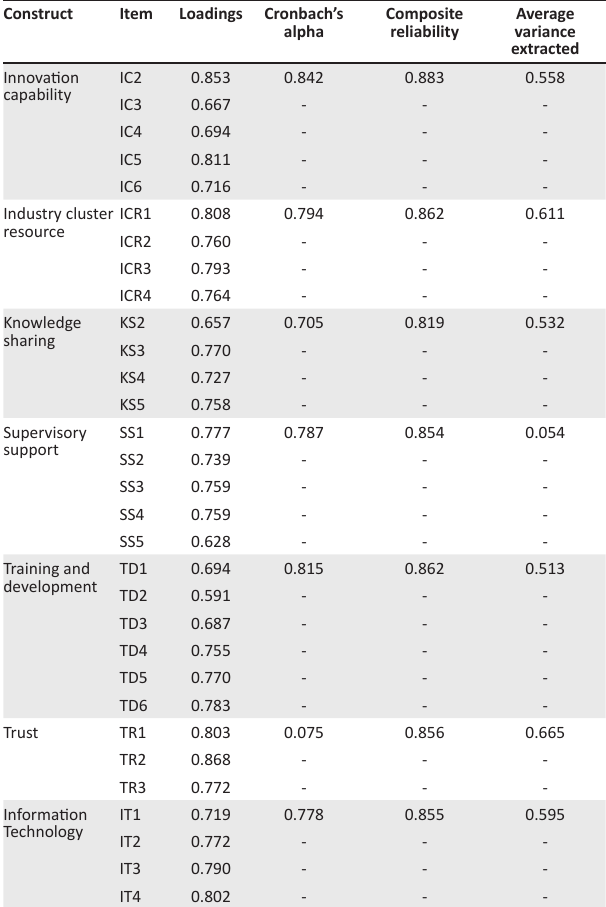
TABLE 2: Convergent validity. Construct